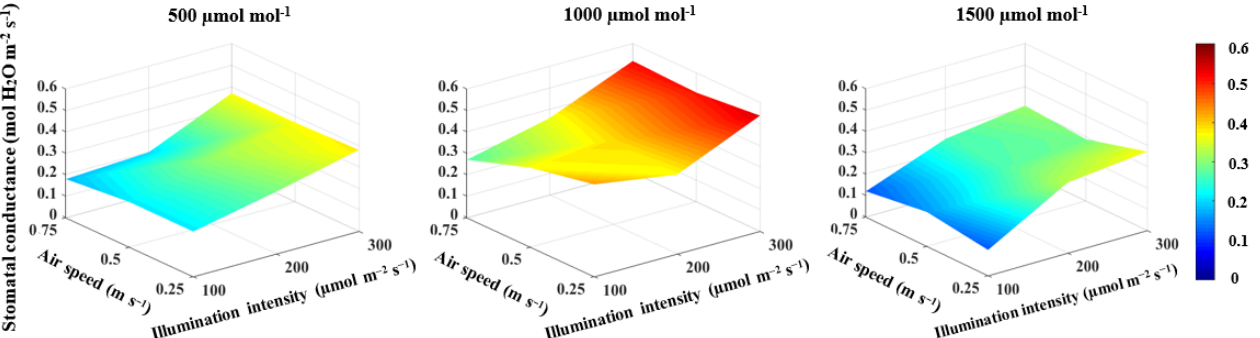
Figure 4. Effect of CO 2 concentration, illumination intensity and air speed on the transpiration rate of lettuce plants grown under artificial lighting.